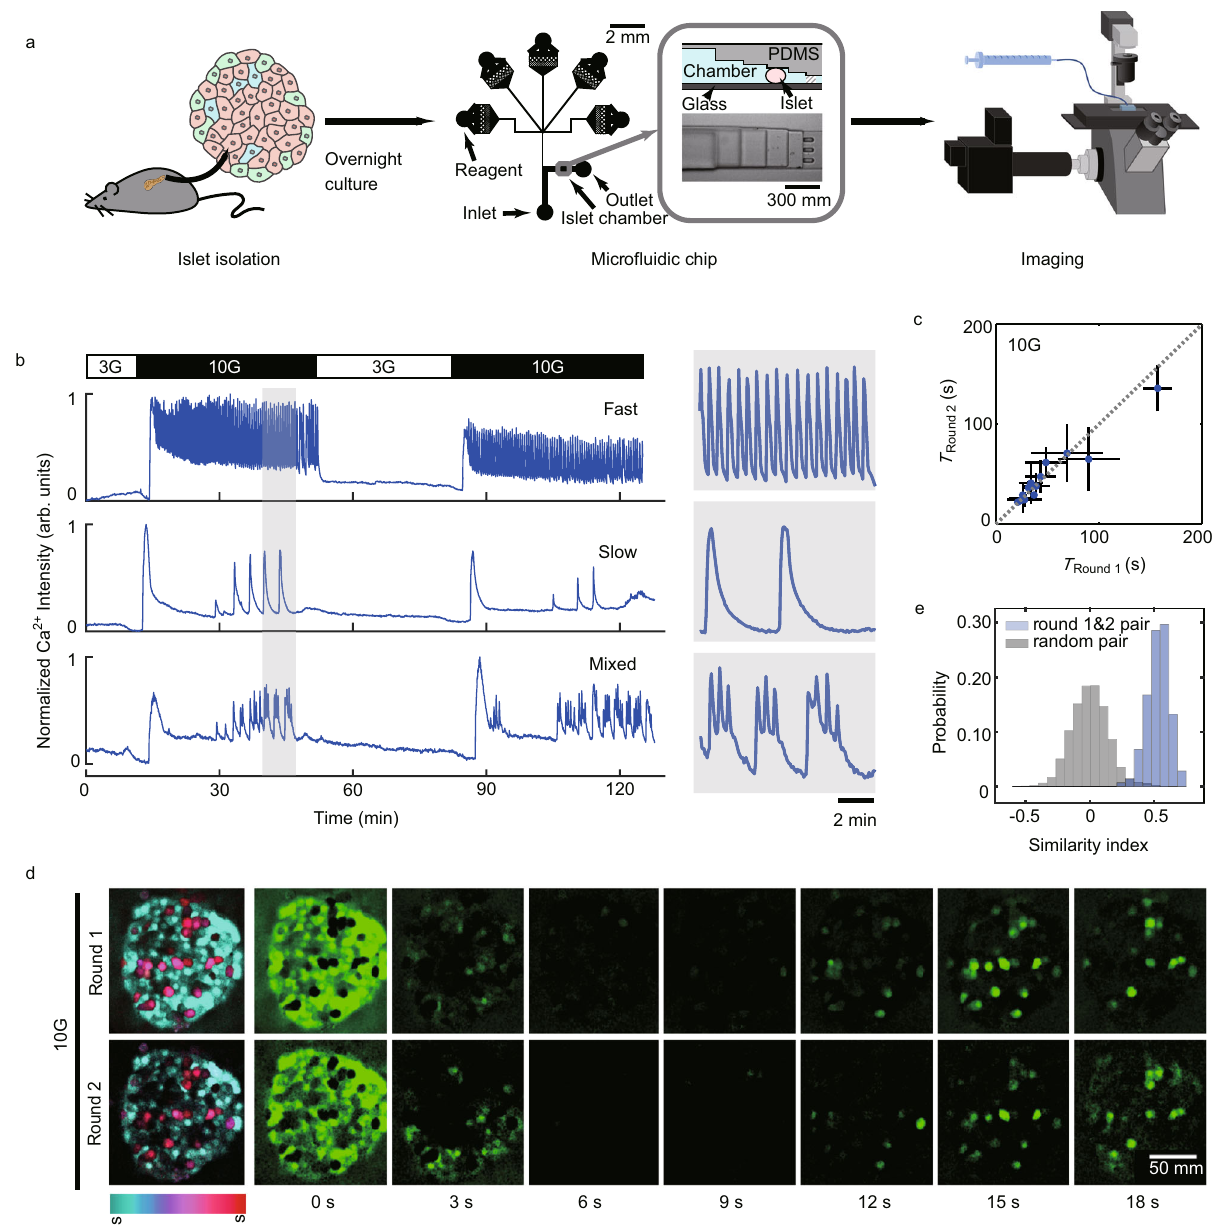
Fig. 1 Islets Show Intrinsic Ca 2 + Oscillation Modes under High Glucose Stimulation. a Experimental fl ow chart. Islets are isolated from mice. After overnight culture, the islets are loaded onto the micro fl uidic chip for imaging with spinning-disk confocal microscopy. The chip comprises fi ve reagent channels, an inlet channel and an outlet channel. The islet chamber traps the islet with a gradient height from 270 μ m to 50 μ m. b Representative recordings of whole islet Ca 2 + signal in Cal-520 AM loaded islets isolated from C57BL/6 J mouse. The islet is stimulated with a repeated protocol: 10 min 3 mM glucose (3 G), 40 min 10 mM glucose (10 G), 30 min 3 G and 40 min 10 G. The fi rst panel, the islet displays fast oscillations with a period of ~20 s (31 of 46 islets); the second panel, slow oscillations at ~3.5 min (9 of 46 islets); the third panel, mixed oscillations at ~20 s and 2.45 min (6 of 46 islets); Enlarged images of the shaded region are shown on the right. c The mean Ca 2 + oscillation period during the fi rst versus the second round of 10 G stimulation ( n = 14 islets). Bars represent mean ± s.d. (standard deviation). d Cell activation sequence in the fi rst and second round of 10 G stimulation. We subtract the previous frame from the following frame of the original Ca 2 + images (frame interval 3 s). Shown is the cell activation sequence averaged across oscillation cycles in a 5 min interval (aligned with the maximum activation frame). The left panels summarize the time sequence shown in the 7 right panels, with the pseudo-color representing the activation time. e The same islet shows a high similarity index between the fi rst and the second round of 10 G stimulation (5 islets from 3 mice in 3 independent